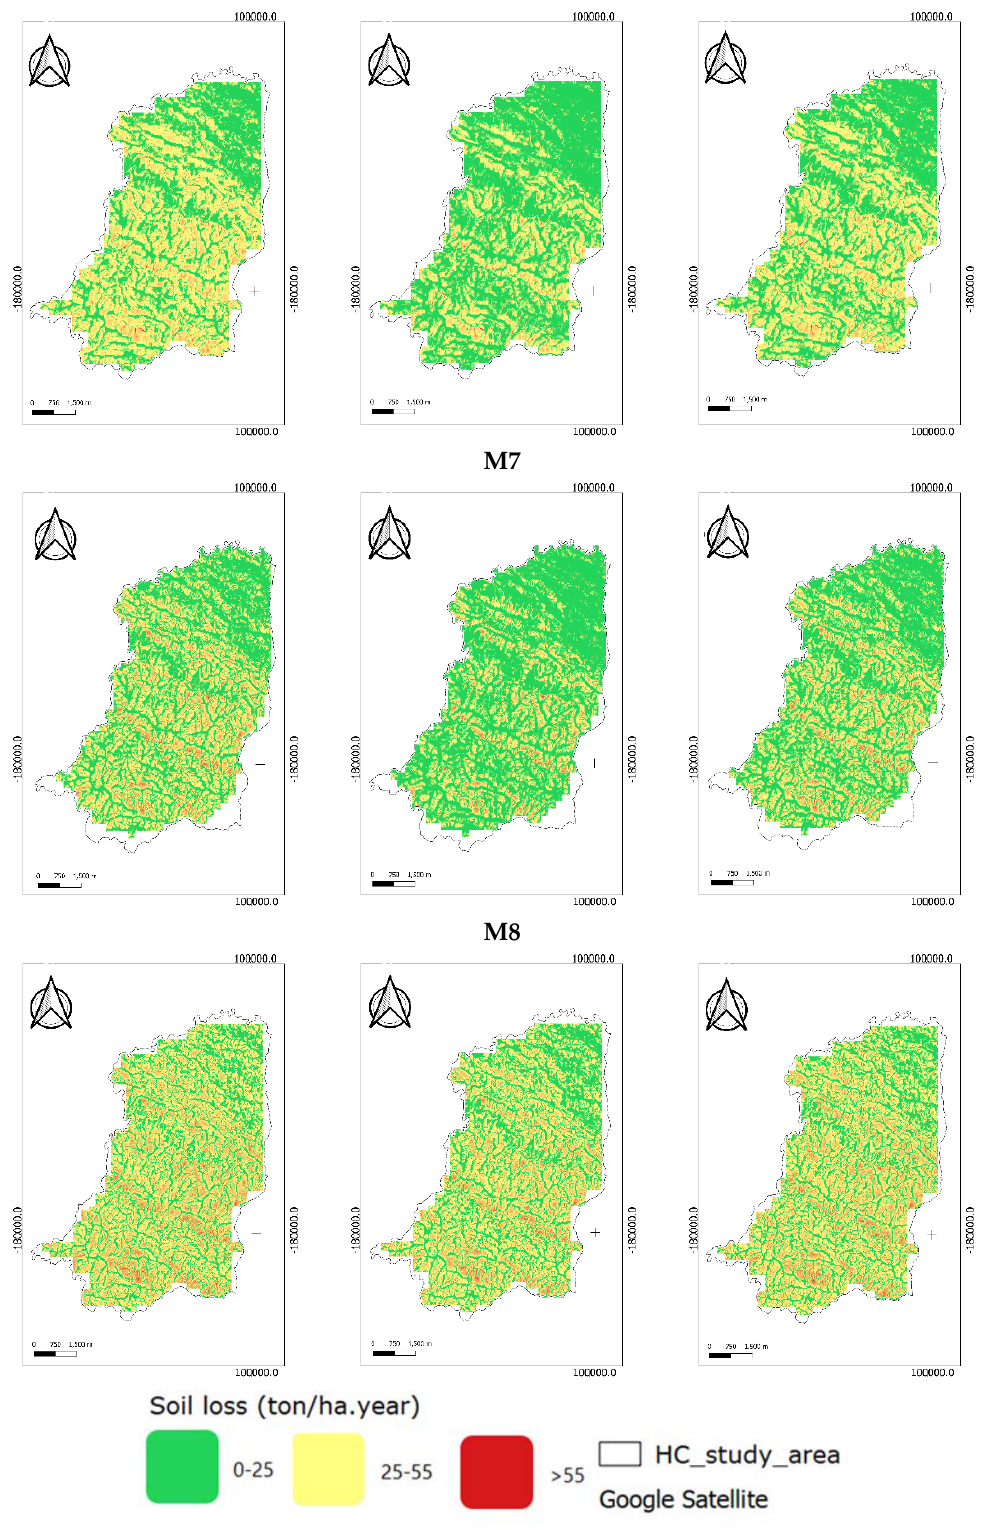
Figure 4. Alentejo erosion soil map results from the eight methodologies and using different combinations ( M1 R w × K w × LS w ; M2 R jrc × K jrc × LS w ; M3 R w × K w × LS m ; M4 R jrc × K jrc × LS m ; M5 R w × K w × LS mw ; M6 R jrc × K jrc × LS mw ; M7 R w × K w × LS mc ; M8 R jrc × K jrc × LS mc ).